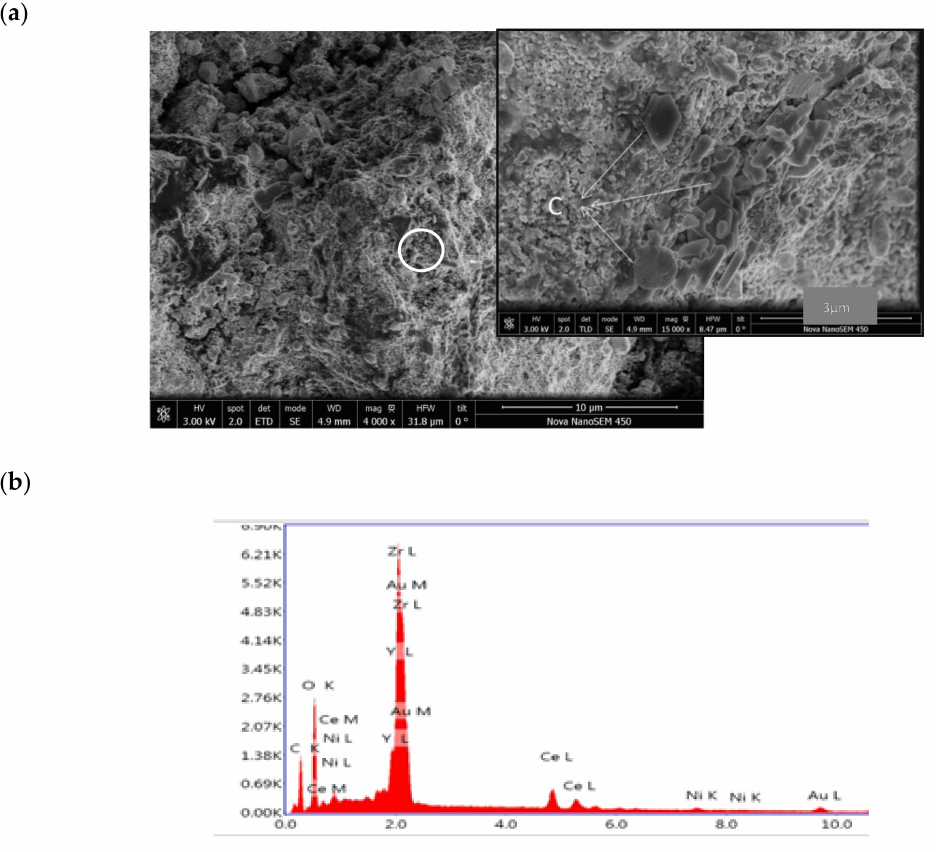
Figure 8. ( a ) SEM micrographs of the anode surface and ( b ) EDS pattern of a selected area of the anode surface after long-term tests in wet (3% H 2 O) and dry CH 4 at 850 ◦